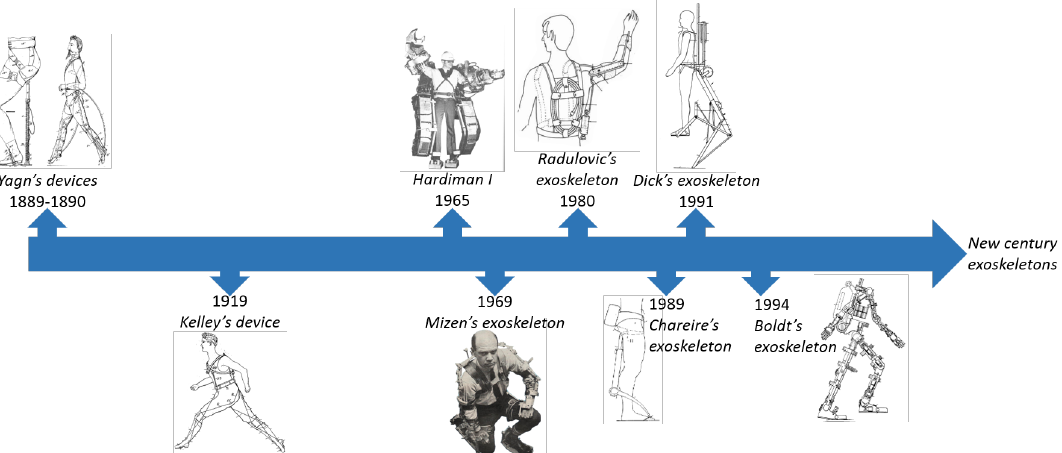
Figure 1. Antique exoskeletons presented chronologically